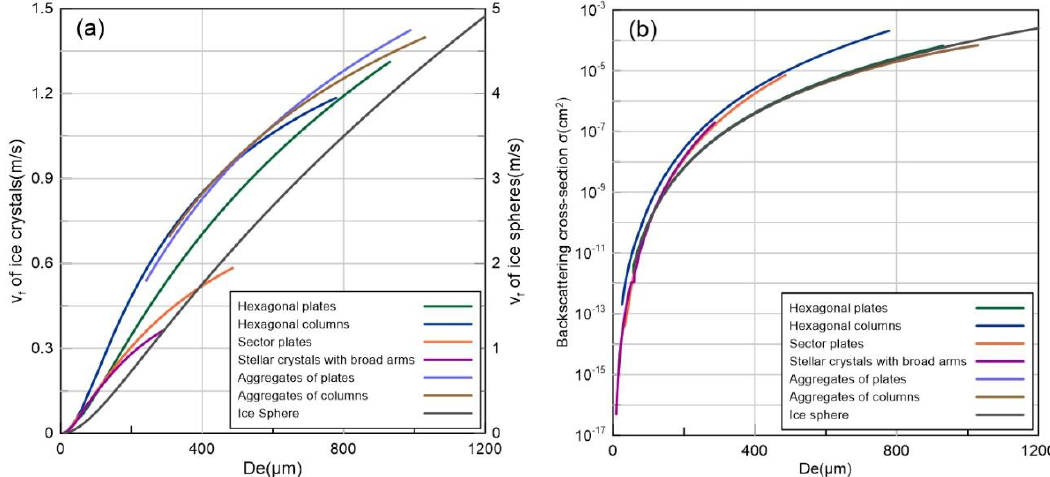
Figure 3. Relationships between the fall velocities of different types of ice crystals and an ice sphere ( a ) and the backscattering cross-section of ice crystals and an ice sphere ( b ). The fall velocity of particles at a height of 4.5 km under standard atmospheric conditions.